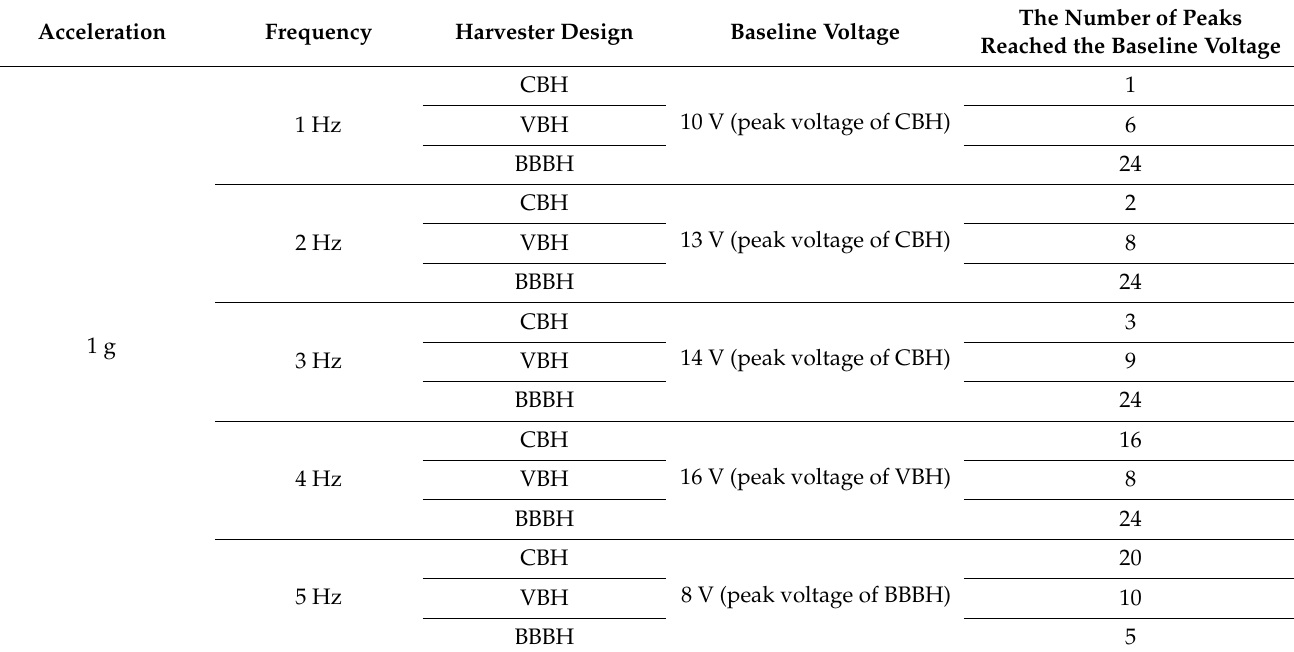
Table 8. Number of peaks obtained for different frequencies within one motion cycle under 1